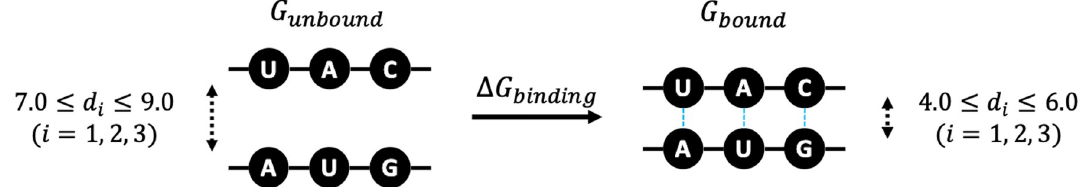
Fig 2. Binding free energy. Schematic representation of G bound , G unbound , and Δ G binding (Eq 3).